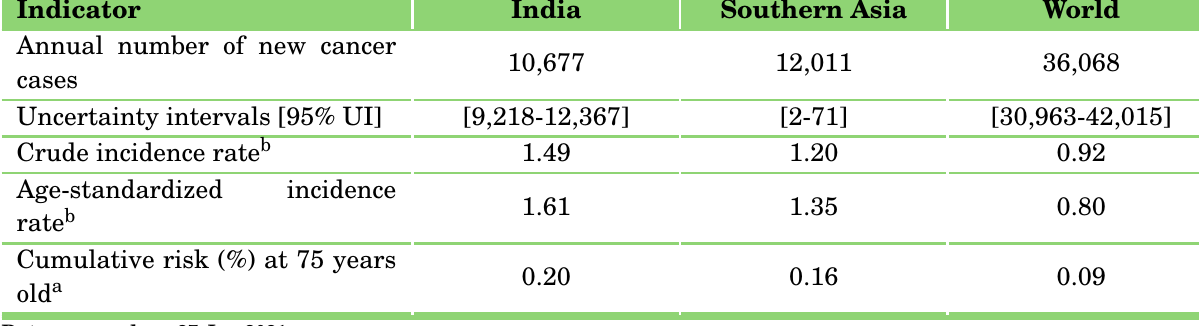
Table 13: Penile cancer incidence in India (estimates for 2020)